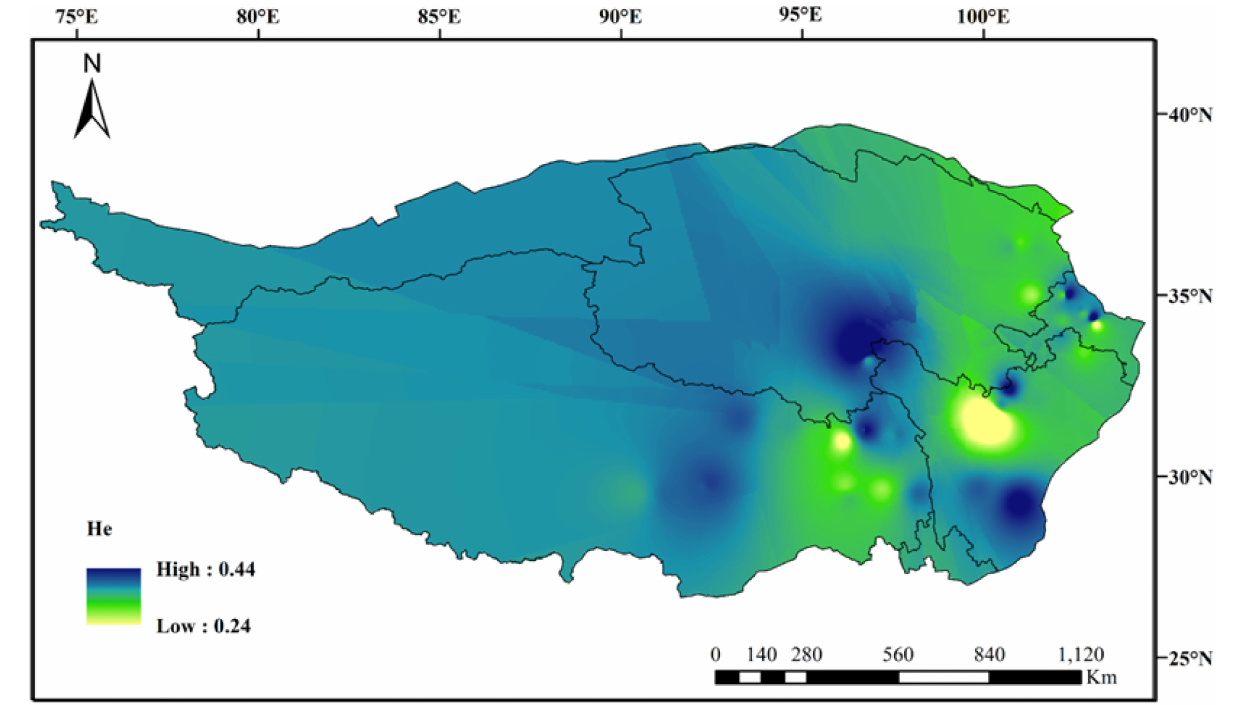
FIGURE 2 | Genetic diversity map of 44 E. sibiricus populations: IDW interpolation of expected heterozygosity values